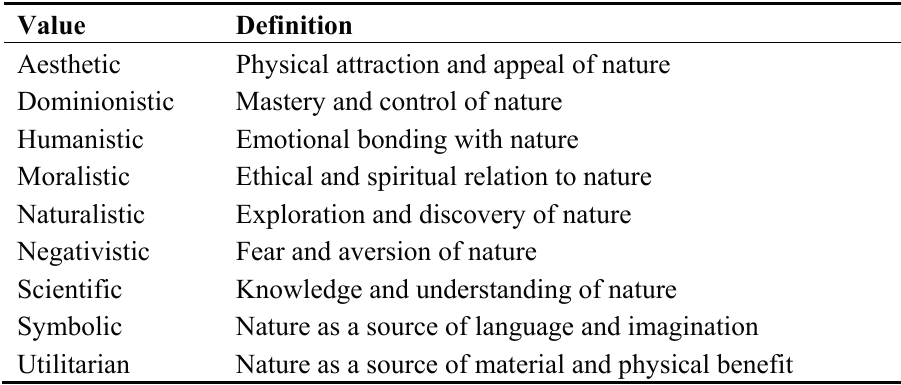
Table 1. A typology of values of nature